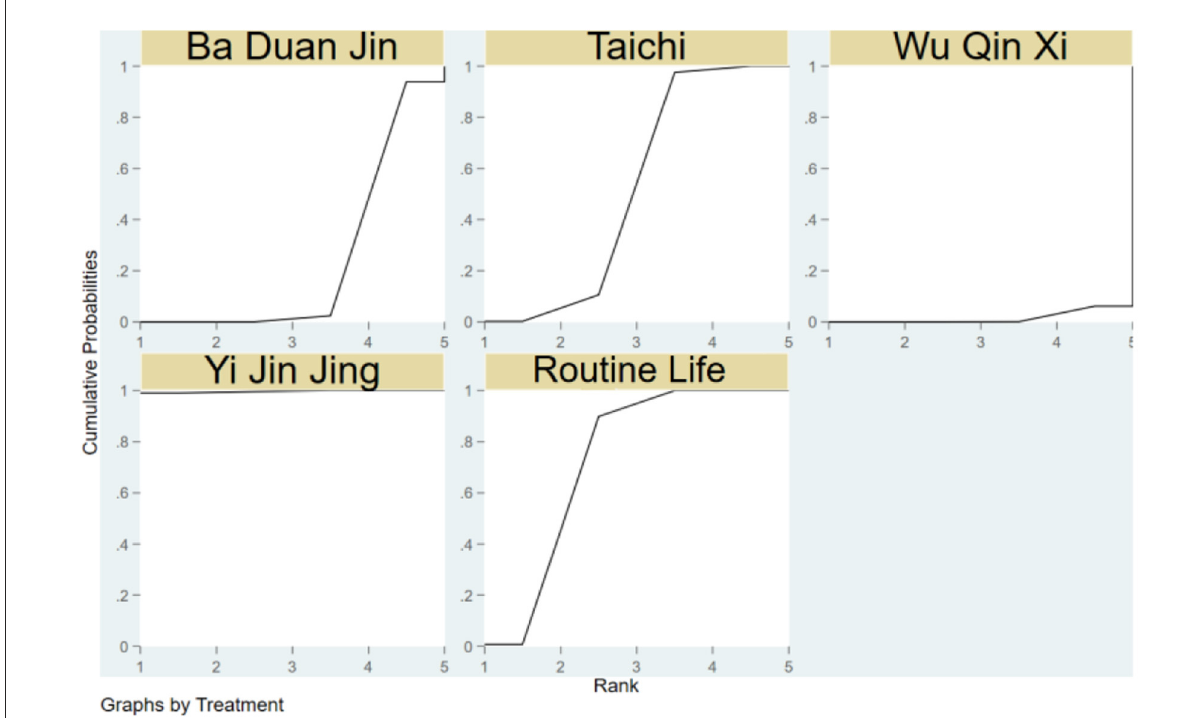
FIGURE8 Cumulative probability SUCRA plots of the effects of different traditional programs on BBS in older adults.